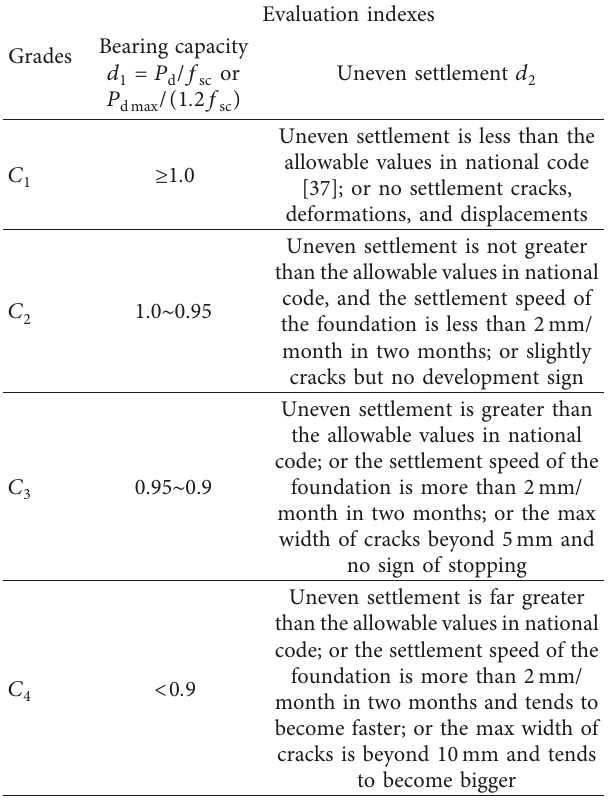
Table 7: Classification standards and evaluation index for foundation.